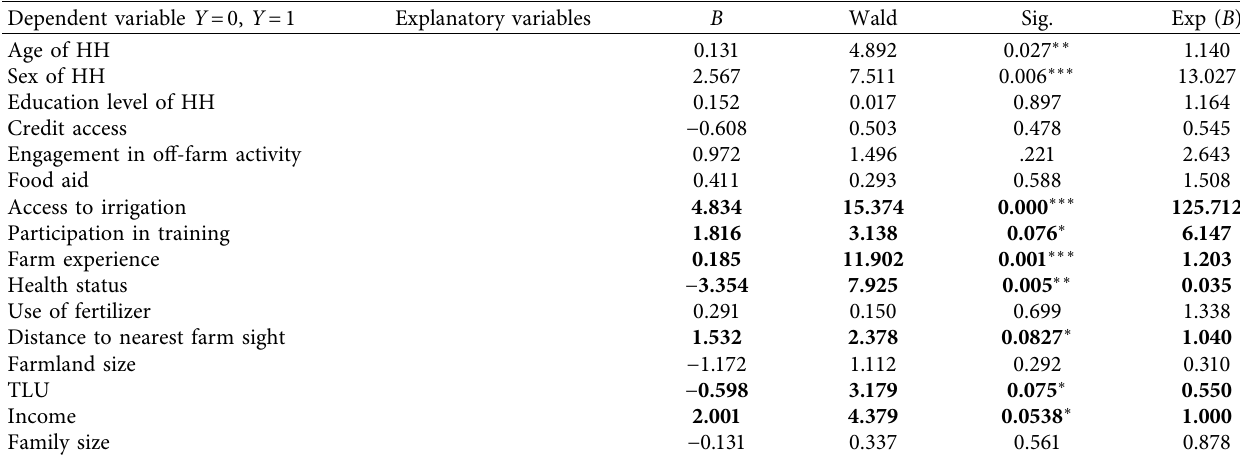
Table 10: Parameter estimation of binary logistic regression on the use of small-scale irrigation by farmers in Offa Woreda 2020. Dependent variable Y � 0, Y �